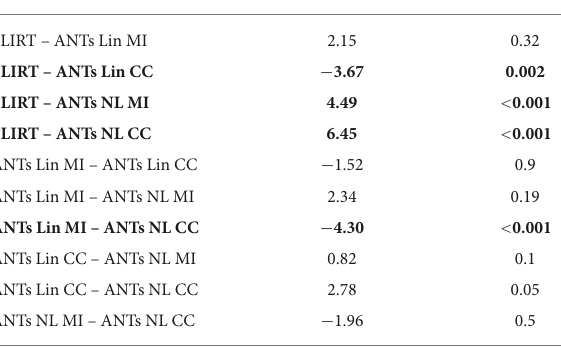
FIGURE7 Comparisons of thalamic and cerebellar volumes produced by FLIRT- or ANTs-based methods relative to manually segmented volumes. The overlap (positive values indicate overestimation, negative values indicate underestimation) is displayed according to the registration methods from top to bottom. Top to bottom: ANTs nonlinear registration (CC, cross-correlation); ANTs nonlinear registration (MI, mutual information); ANTs linear registration (CC); ANTs linear registration (MI); and FLIRT linear